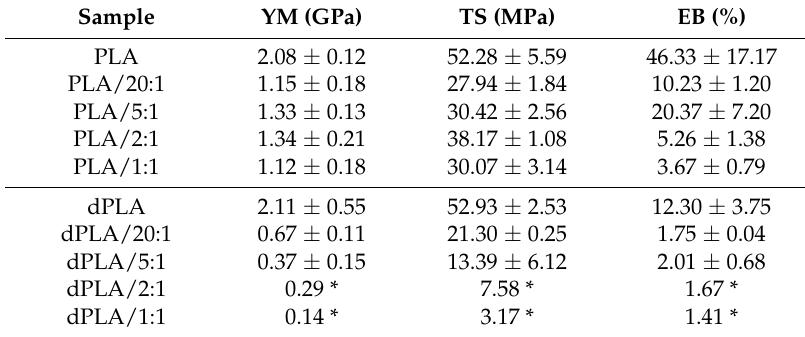
Table 4. Young’s modulus (YM), tensile strength (TS), and elongation at break (EB) parameters calculated for PLA films before and after